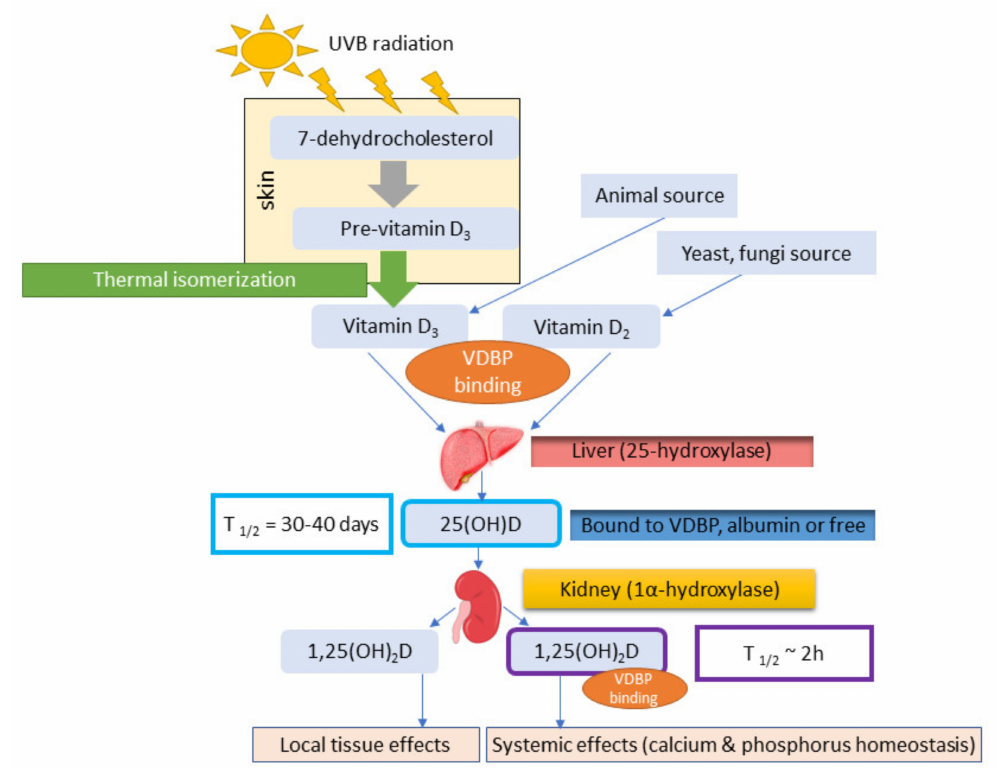
Figure 1. Vitamin D synthesis pathway (based on Bikle 2014 [14])